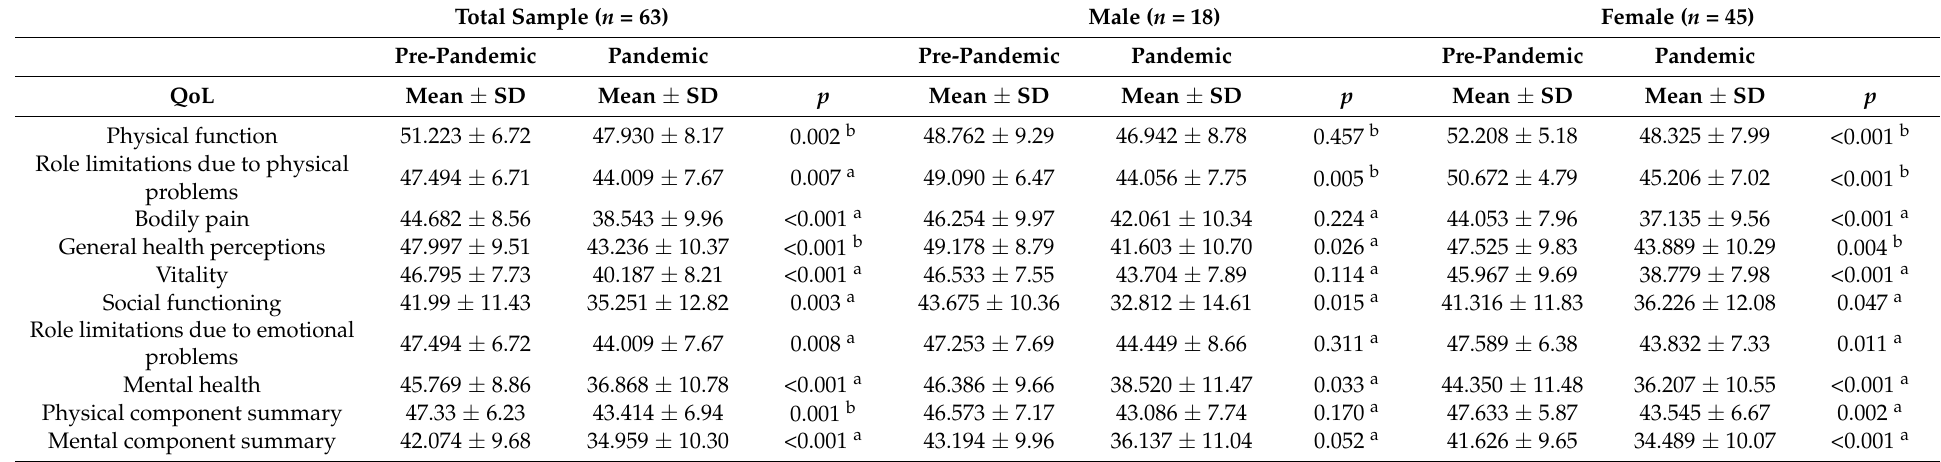
Table 2. Comparison of Short-Form 36 Health Survey (SF-36) measurements of 8 scales and quality of life (QoL) summary measurements evaluated in pre-pandemic and pandemic timeframes in the total sample and each